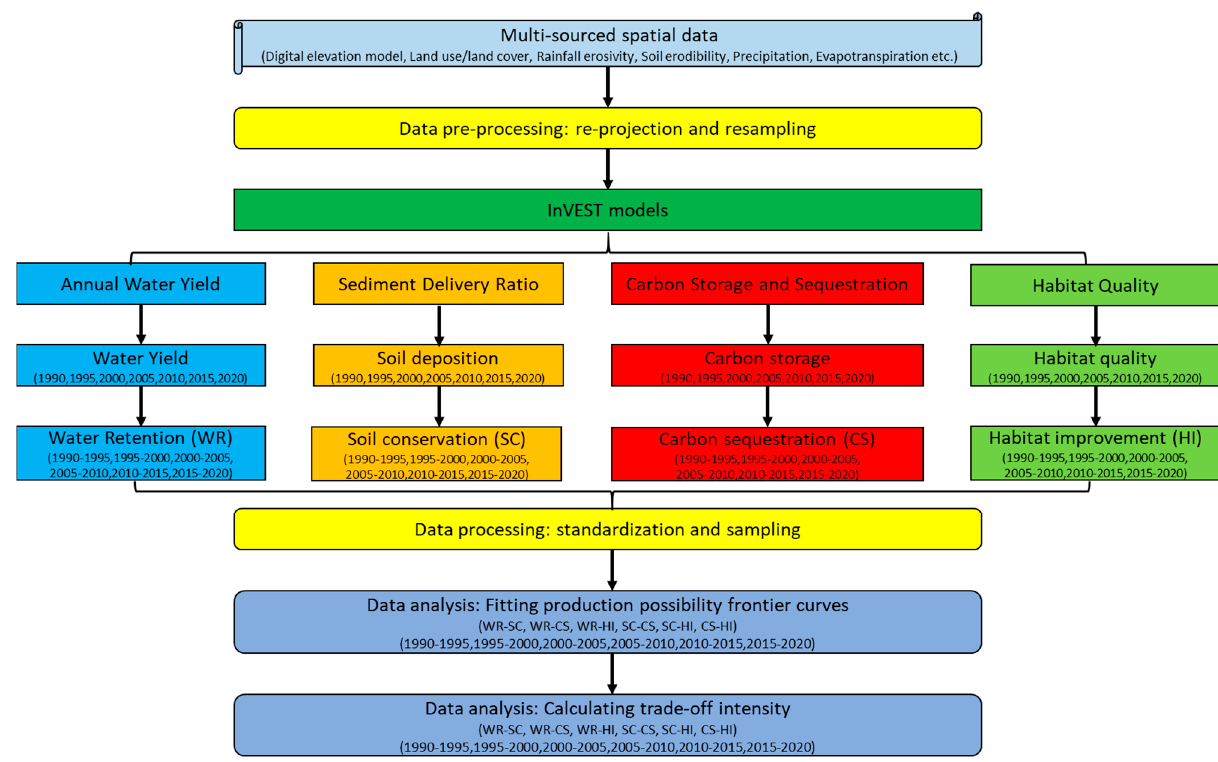
Figure 3. The approach for fitting PPF curves and calculating trade-off intensity.